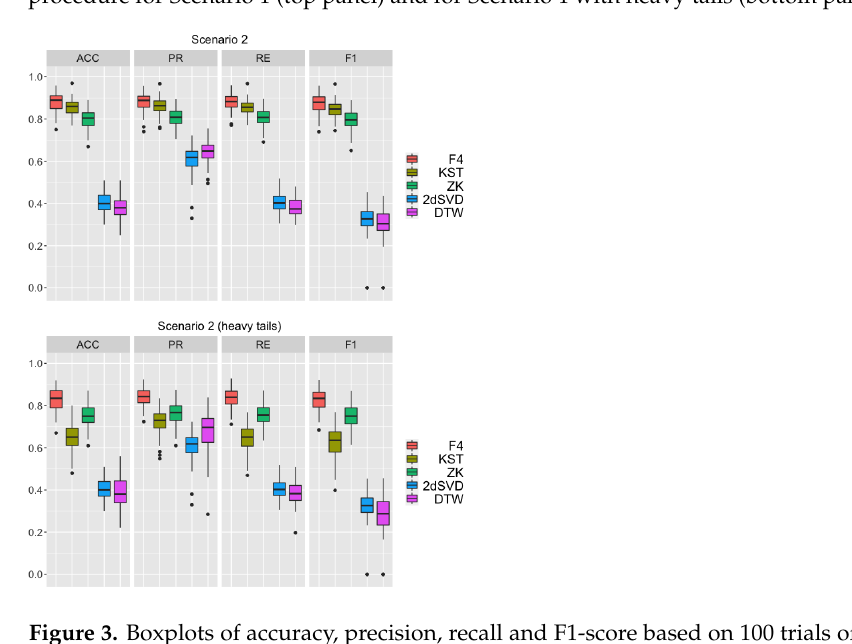
Figure 2. Boxplots of accuracy, precision, recall and F1-score based on the 100 trials of the simulation procedure for Scenario 1 (top panel) and for Scenario 1 with heavy tails (bottom panel).